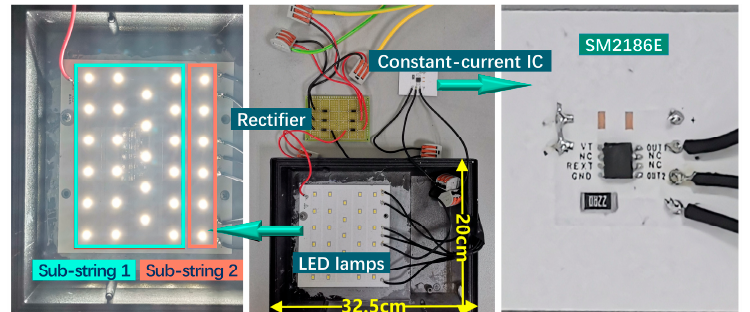
Figure 6. Experiment of the novel pulsating DC high-voltage linear driving scheme for double-string GaN LED.